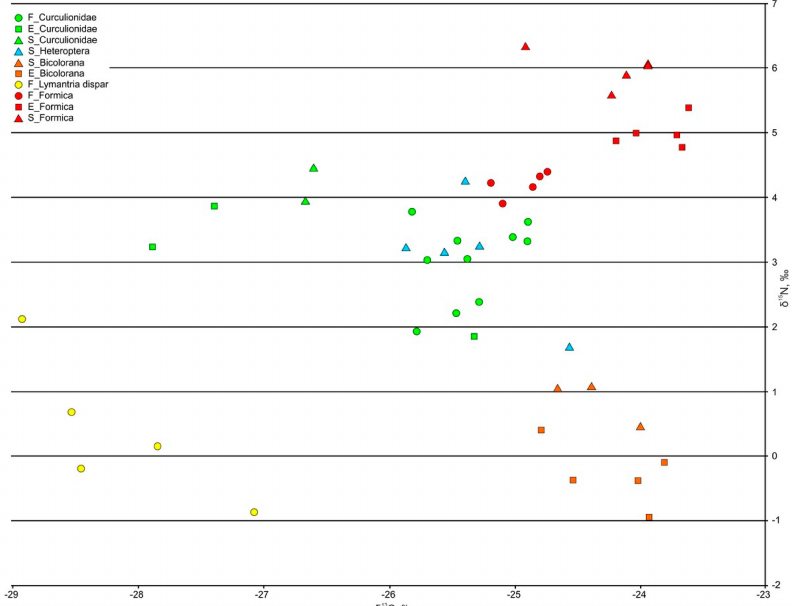
Figure A1. Distribution of phytophagous insects and ants of the studied ecosystems in the δ 13 C– δ 15 N isotopic biplot. Each symbol shows one specimen. F: forest (circles), E: edge (squares), S: steppe (triangles).